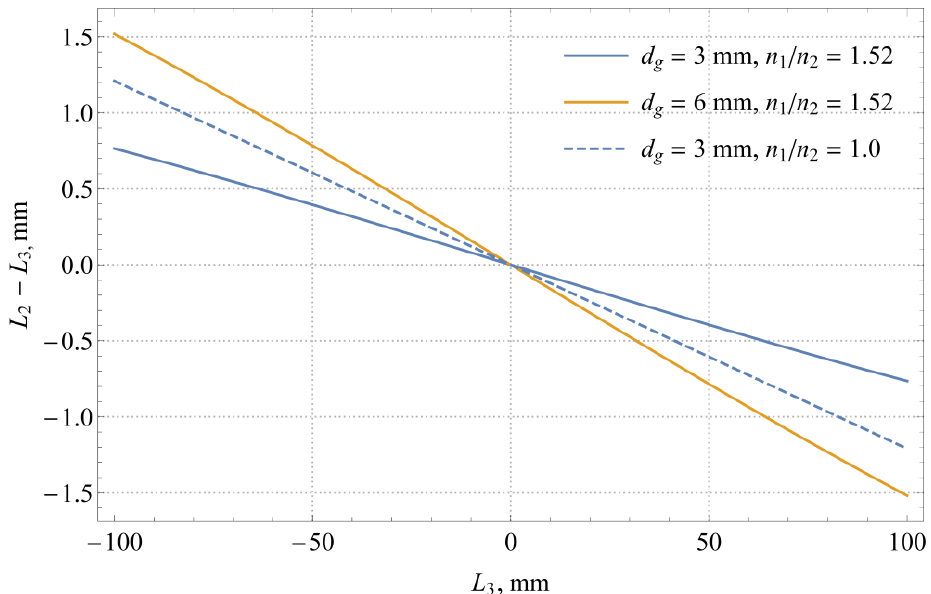
Figure 3. Magnitude of parallax effect L 2 − L 3 (simulation made for d = 240 mm and d s = 5 mm).